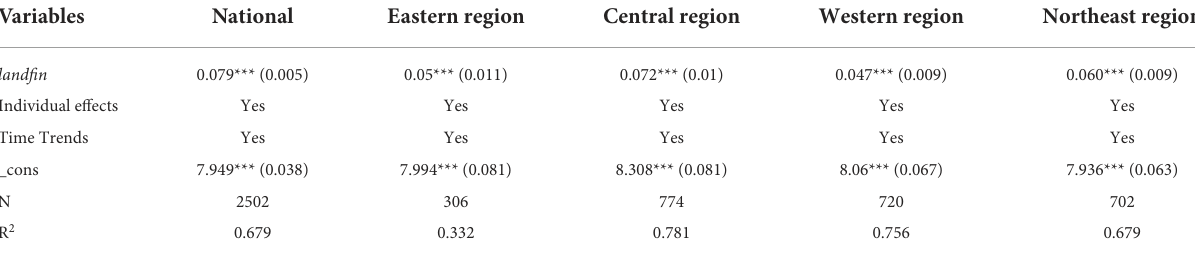
TABLE 5 The results of land finance impacting on housing